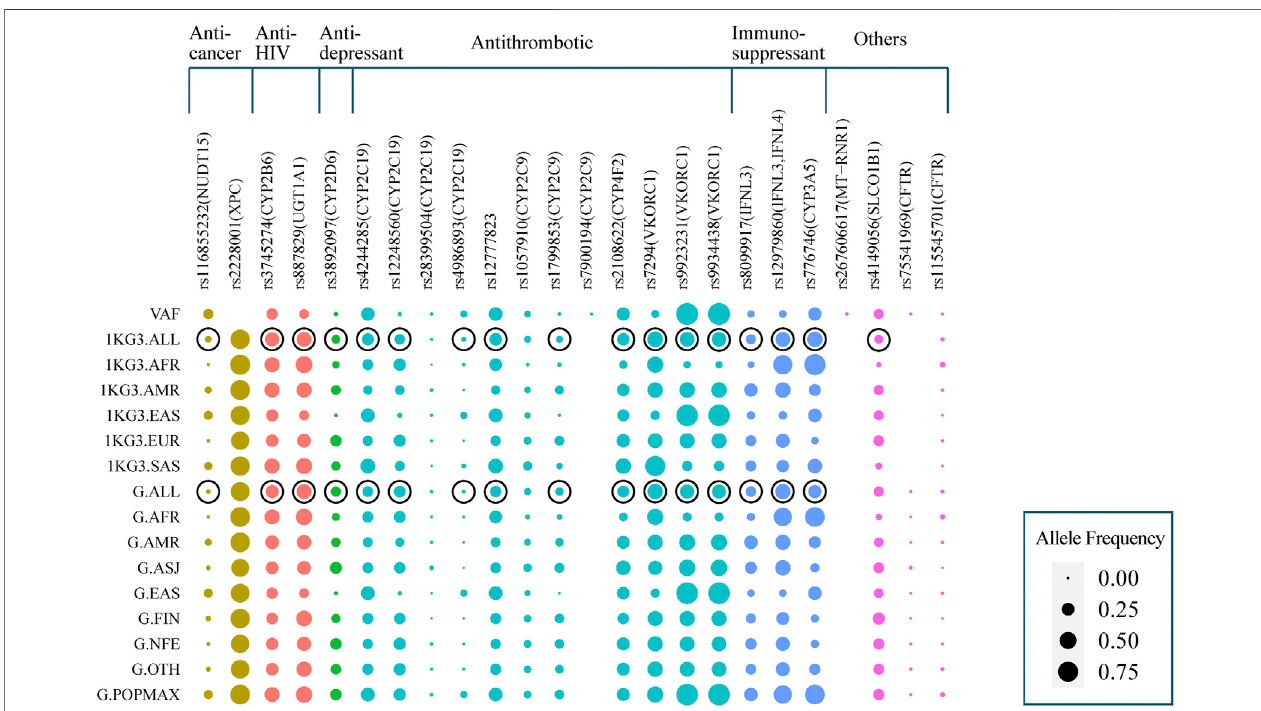
FIGURE 5 | Comparison of the Han Chinese allele frequencies of clinically signi fi cant PharmGKB variants with populations included in 1000 Genomes Project phase 3 (1KG3) and gnomAD databases (G). The variants are arranged according to the category of drugs they affect. The size of the solid circle represents the allele frequencies ranging from 0.00 to 1.00. The black outer ellipse represents that the variant allele frequency of Han Chinese has a statistical difference compared to global population averages (1KG3.ALL and G.ALL).